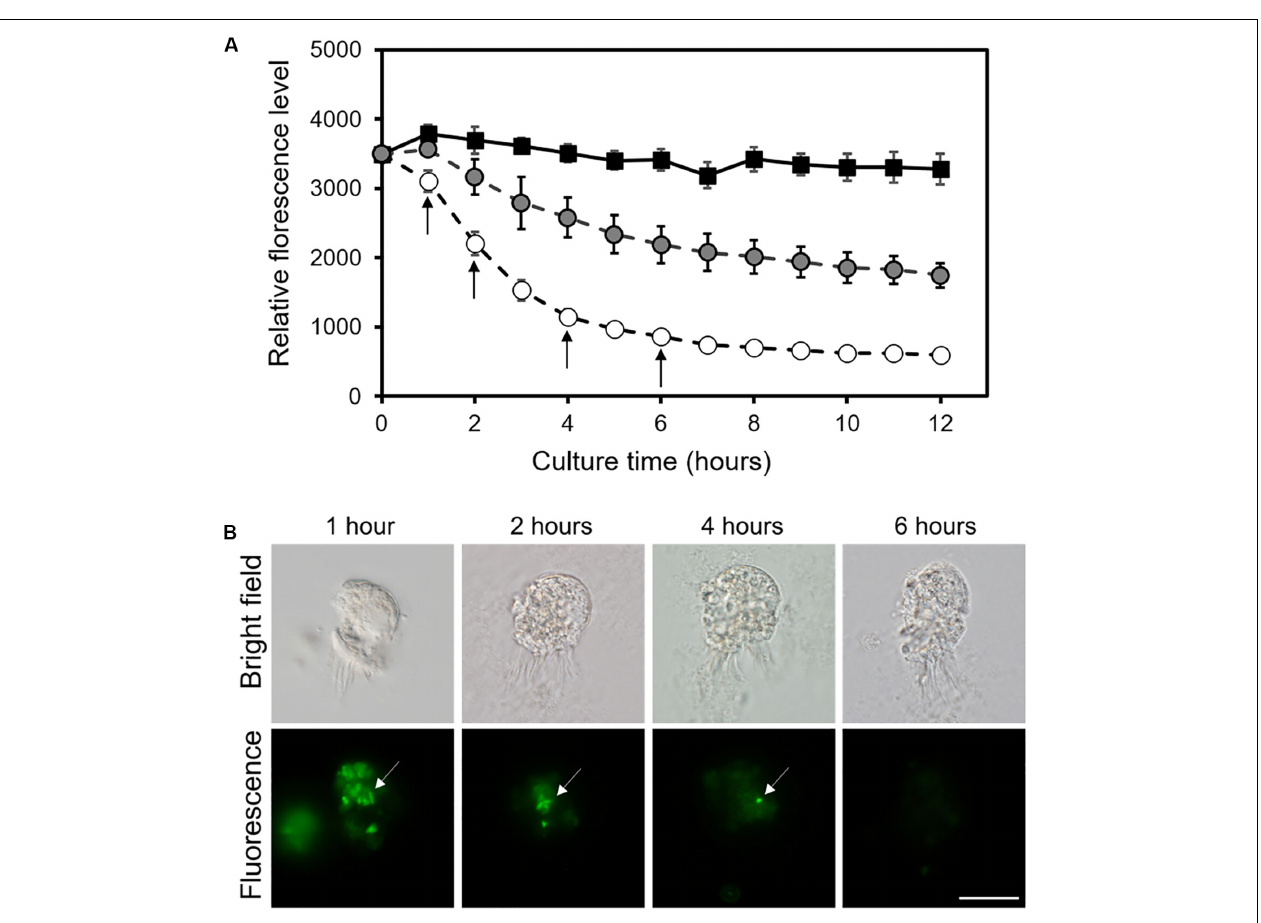
FIGURE 4 | Immunofluorescent staining of Strombidium sp. NTOU1. The microtubule structure and nucleus of Strombidium sp. NTOU1 were labeled using the anti-alpha tubulin antibody (red) and DAPI stain (blue), respectively. Scale bar, 50 µ m.